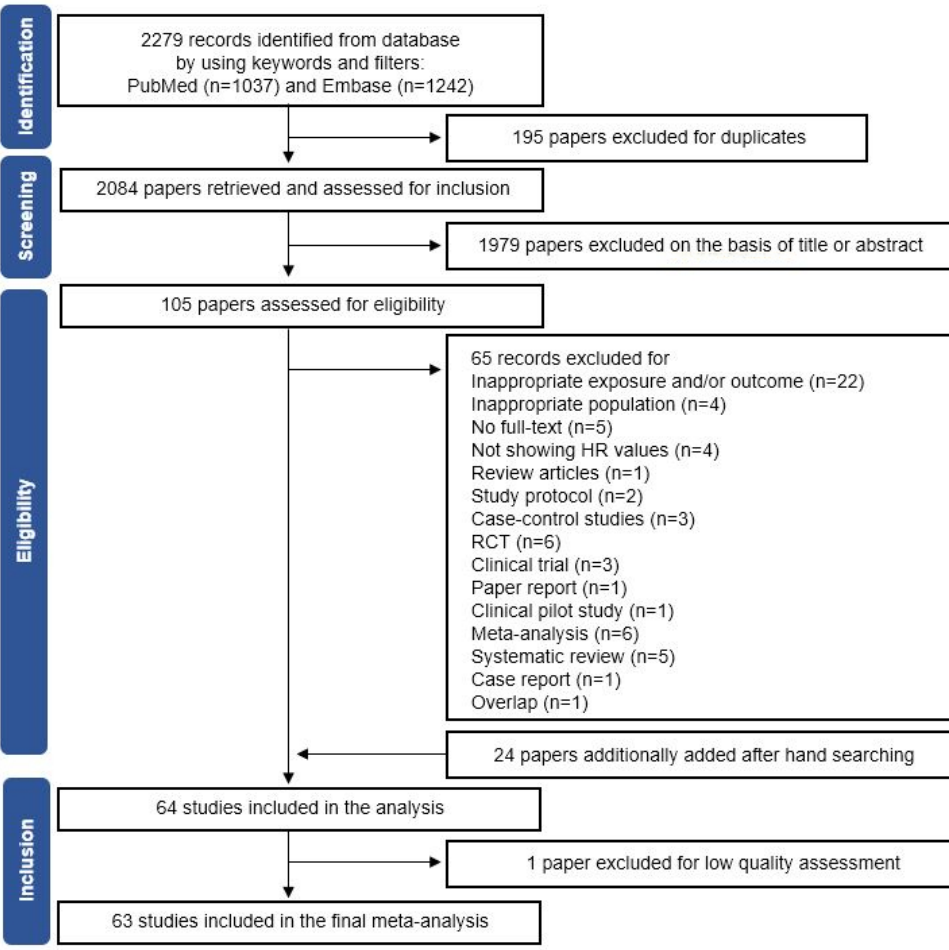
Figure 1. Flow chart of study selection. The flow chart shows the process used to select cohort studies for the systematic review and meta-analysis of the association between dietary factors and breast cancer prognosis among breast cancer